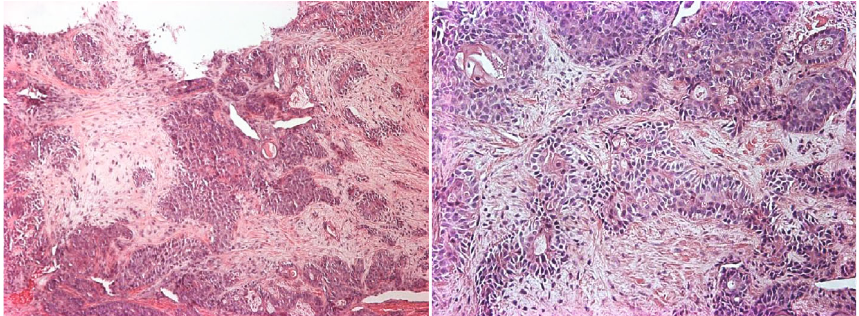
Figure 3: Photomicrographs of hematoxylin and eosin (H&E) staining of the pleomorphic adenoma. Ovoid or polygonal cells, duct-like structures, and fi brous stroma showing areas of myxoid changes are